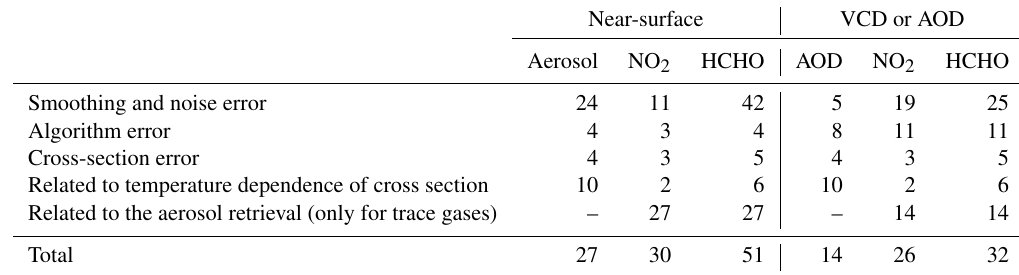
Table 3. Averaged error estimation (in %) of the retrieved near-surface (0–100m) trace gas concentrations and AECs and of trace gas VCDs and AOD.